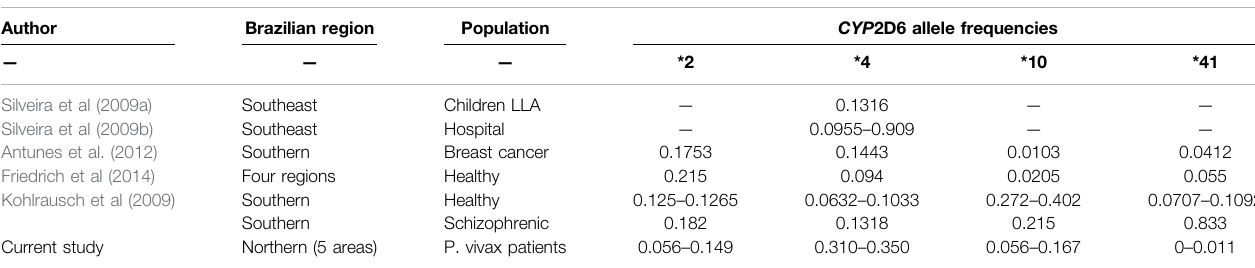
TABLE 2 | Frequency distribution of CYP 2D6 alleles in distinct populations according to Brazilian